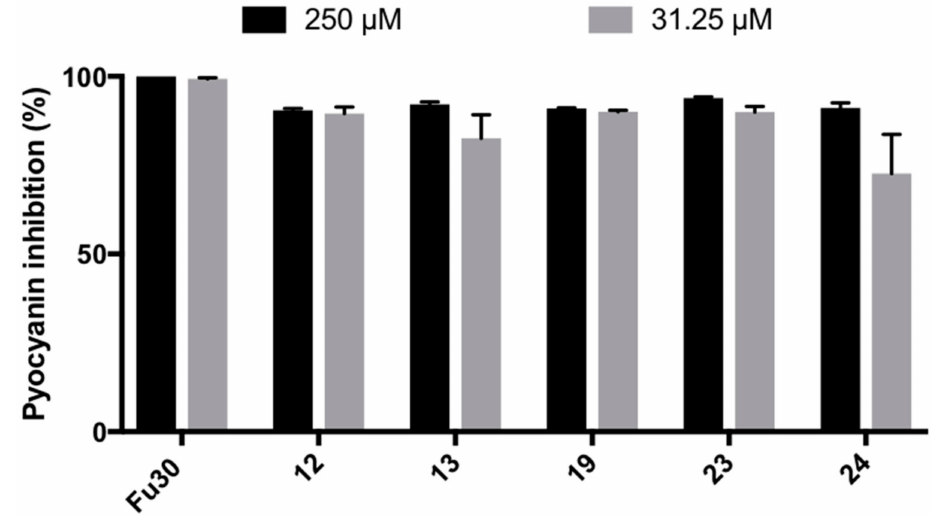
Figure 2. Pyocyanin inhibition in P. aeruginosa PAO1 by the synthesized compounds. Compounds were added to the bacteria at 250 µ M or 31.25 µ M and were incubated for 17 h with shaking. Pyocyanin production was measured at 695 nm in cell-free culture fluids. Error bars represent the standard error of two independent